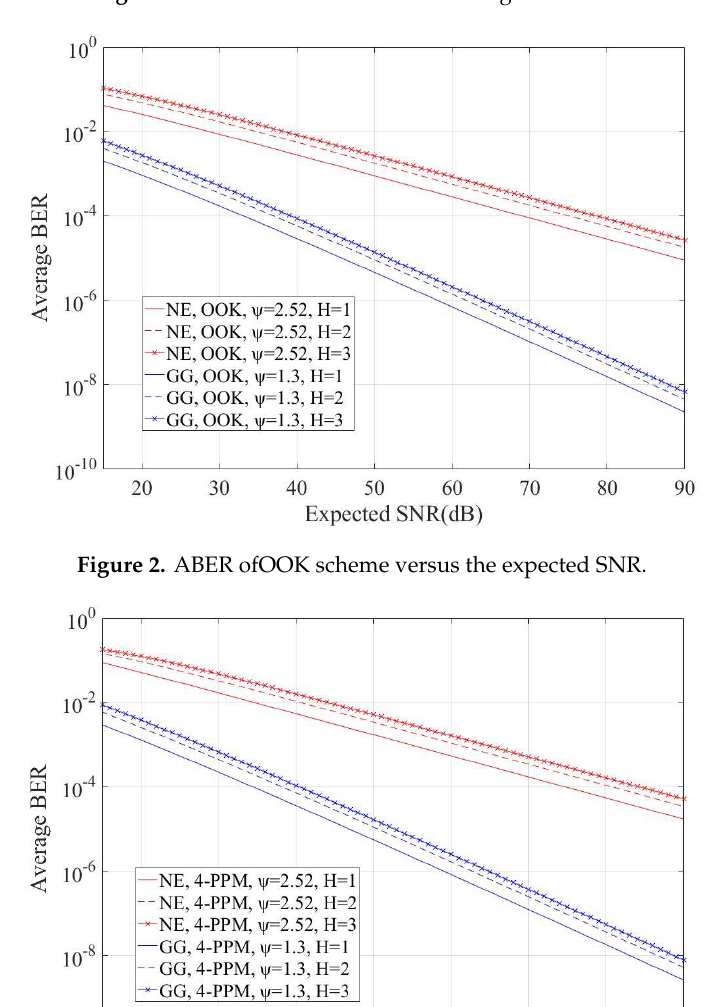
Figure 4. ABER of16-PPM scheme versus the expected SNR.